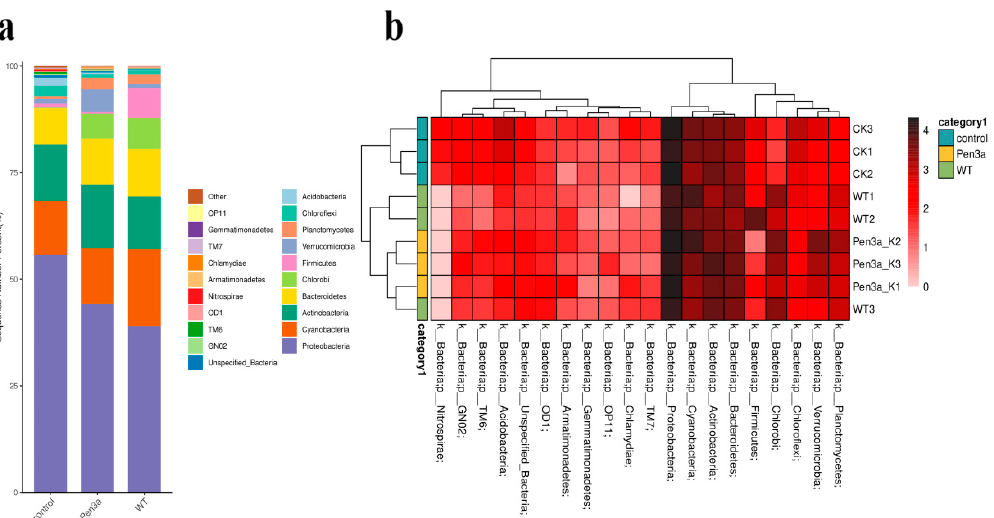
Figure 5. Abundance of the bacterial community in aquaculture water after 14 days treatment. ( a ) Phylum taxonomic distribution. The abscissa represents three processing methods, and the ordinate represents the ratio of the number of series at the level of the gate to the total annotation data. It means the top 20 microbial phyla with relative abundance. ( b ) Heatmap of microbial community structures at the phylum level.